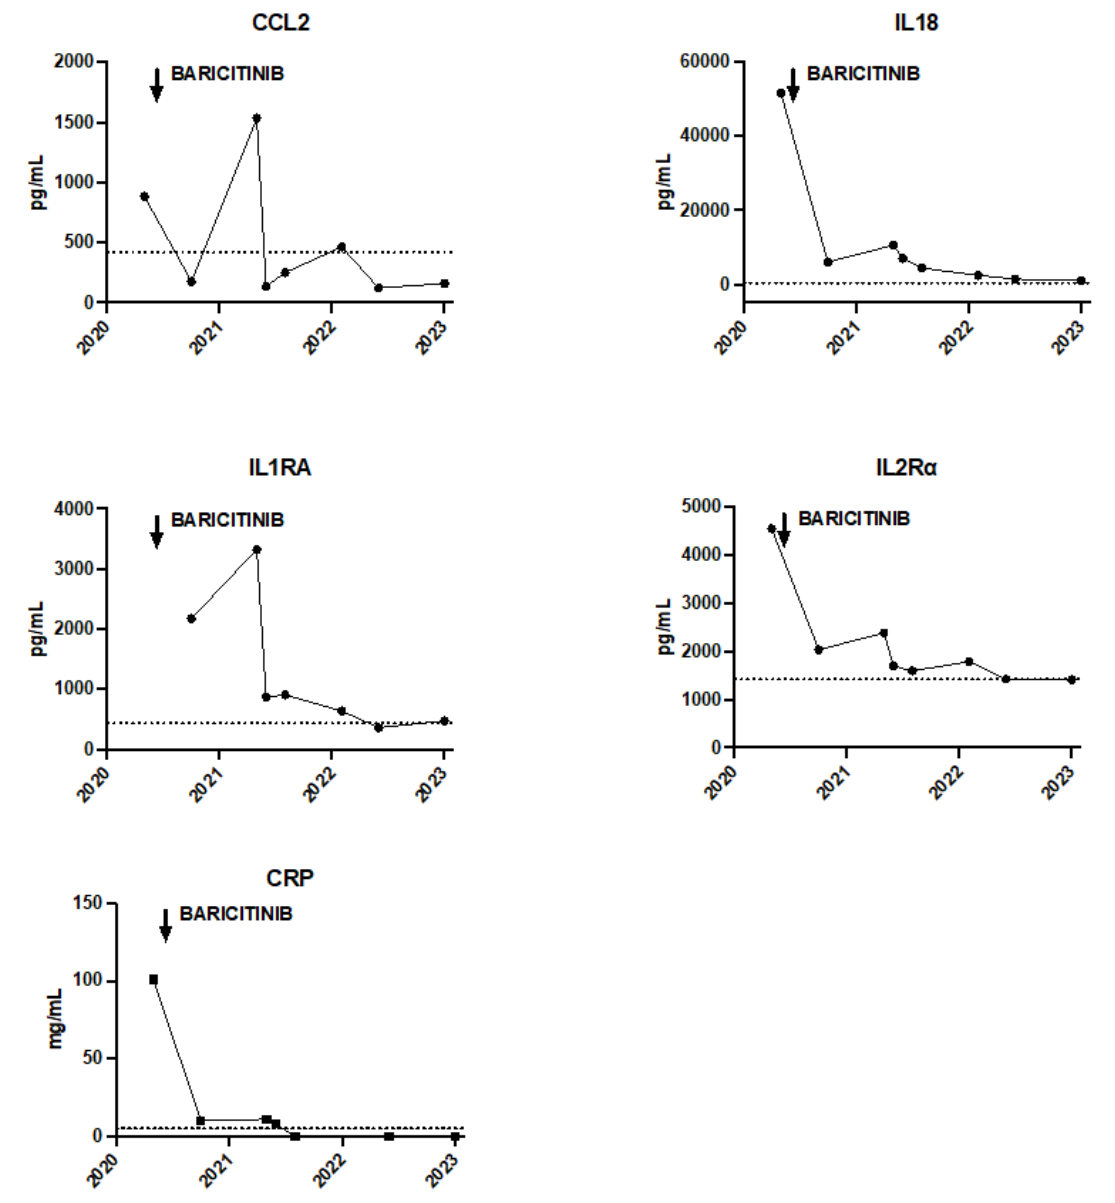
Figure 3. Evolution of the different inflammatory markers with the initiation of Baricitinib. The dotted line corresponds to the upper limit of normal values.